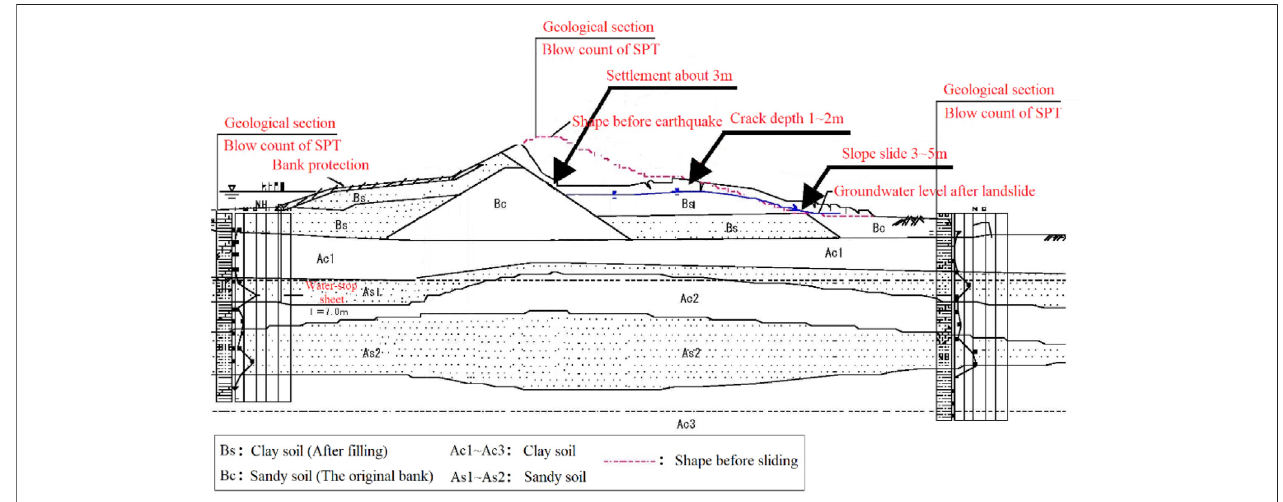
FIGURE 4 | Schematic diagram of the bank slope failure.